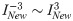
Image generation from a single image(I
0) by using BIF.(a) images for each light category(C
−3 ∼ C
3). (b) generated images(INew-3∼INew3).